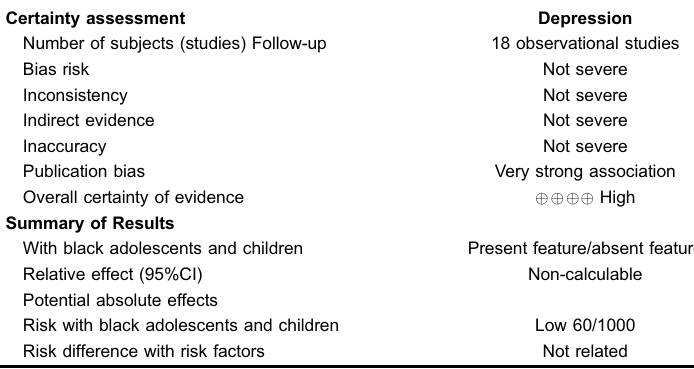
Table 2. Bias between studies according to the GRADE